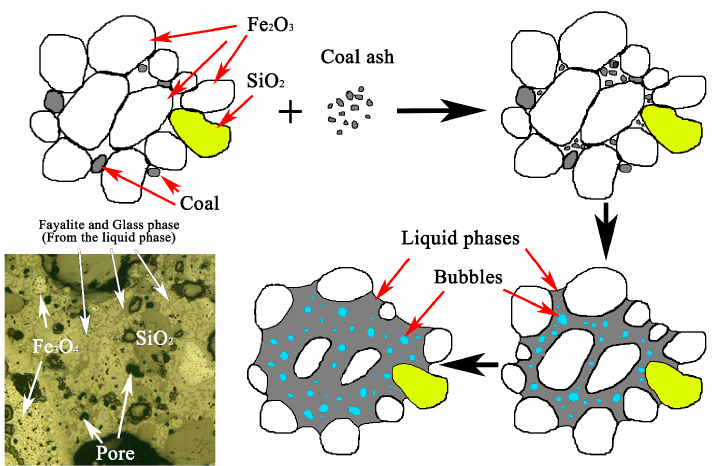
Figure 10. Schematic diagram of kiln wall deposit formation.